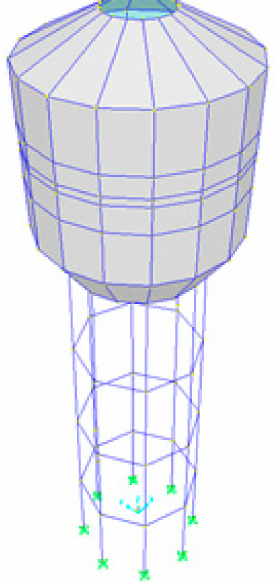
Figure 14. FE model of the concrete water